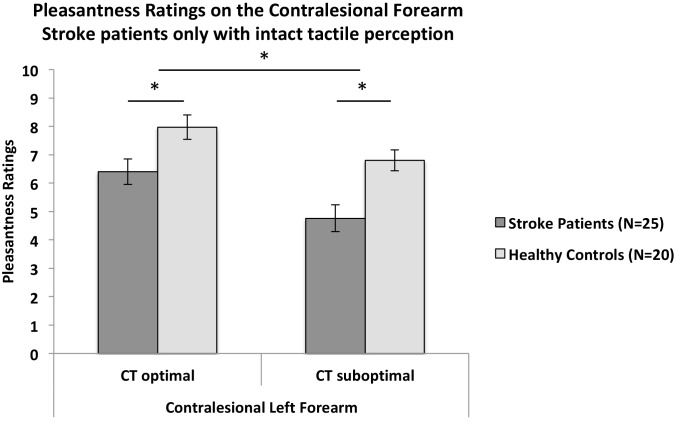
Average pleasantness ratings on the contralesional left forearm for patients with intact tactile perception in dark gray (NRH = 25). Results for healthy controls are the same as presented in Figure 1. C, in light gray (NHC = 20). Error bars represent the standard error of the mean.